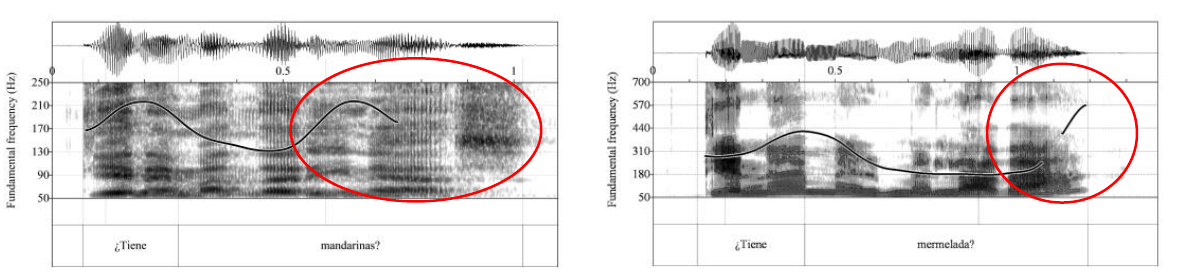
Figure 3. Examples of Spanish yes-no questions with a falling contour (left, Buenos Aires Spanish) and a rising contour (right, México DF Spanish)